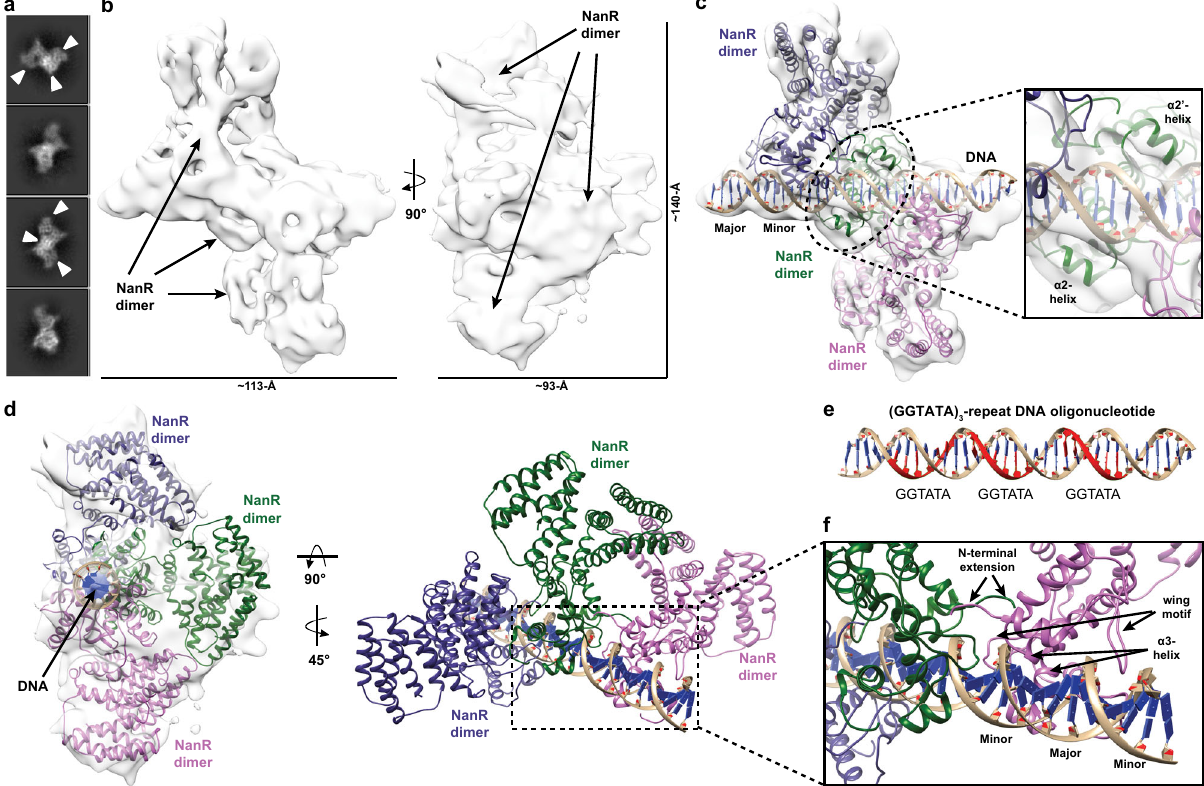
Fig. 7 Cryo-EM structure of the NanR-dimer 3 /DNA hetero-complex. a 2D class averages showing three possible NanR dimers bound to DNA in projection (white arrow). b Density map for the NanR-dimer 3 /DNA hetero-complex. c Three NanR dimers and a DNA duplex were fi tted using a rigid body method. Two NanR dimers are clearly visible within the density (gray isosurface) at each end of the DNA, while the middle dimer is less resolved as a result of orientation bias. The DNA fl anking α 2-helices provide fi t con fi dence for the middle NanR dimer (green, inset). d Each NanR dimer is offset by approximately one half turn of the DNA helix. e Each GGTATA repeat of the DNA operator (in red) is separated by less than half a turn of the DNA helix. f Zoomed view of the NanR – DNA interface highlighting how each NanR bound to the (GGTATA) 3 -repeat operator maintains an analogous binding mode to the NanR-dimer 1 /DNA hetero-complex (Fig. 5), where the α 3-helix binds in the major groove and the wing motif accommodates the minor groove of DNA. The N-terminal domains are hypothesized to interact with each other, given their proximity, through protein – protein interactions in the higher-order